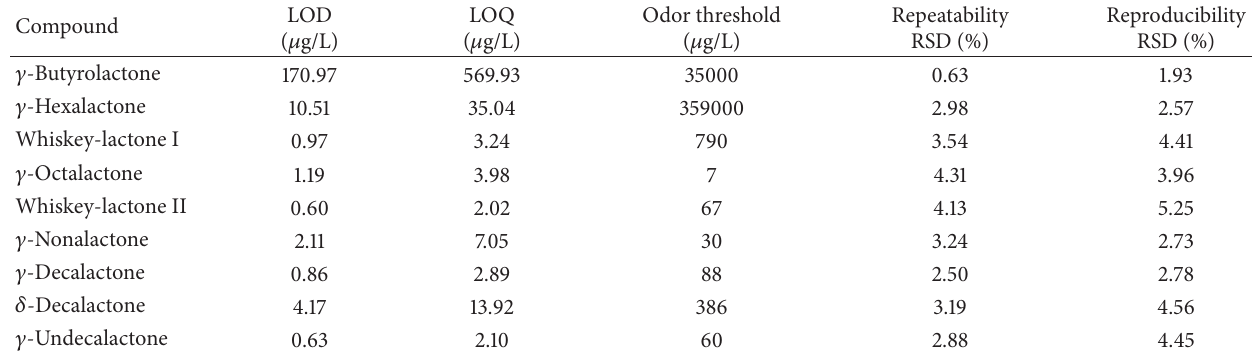
Table 6: LOD, repeatability, and reproducibility of method